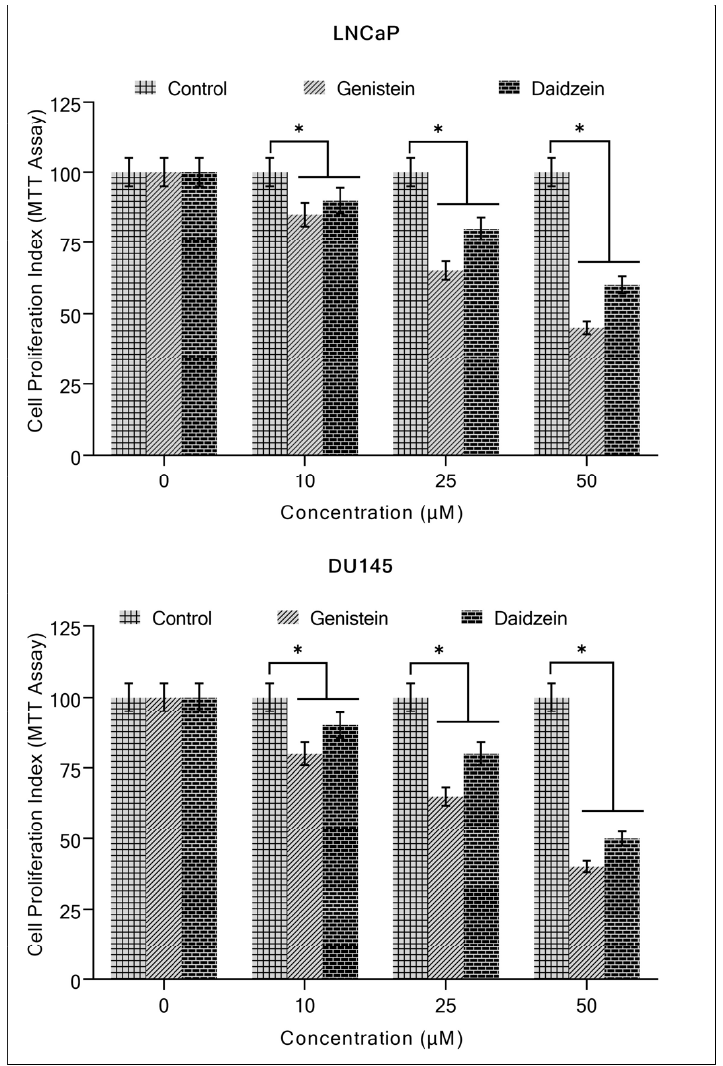
Figure 2. The effect of genistein and daidzein on the proliferation of prostate cancer cell lines determined by the MTT assay. The LNCaP and DU145 cancer cell lines were grown with genistein and daidzein at the given concentrations for 96 h. The effect on cell proliferation was performed by MTT assay as described in Section 4. Values reported are mean ± S.E of triplicate experiments. * p < 0.01 compared to the untreated control (0 µ M of the isoflavone). For further validation of these results, a Histone/DNA ELISA assay was used (Figure 3). This experiment confirmed that both isoflavones (genistein and daidzein) are potent apop- tosis inducers and exhibit a dose-dependent cytotoxic